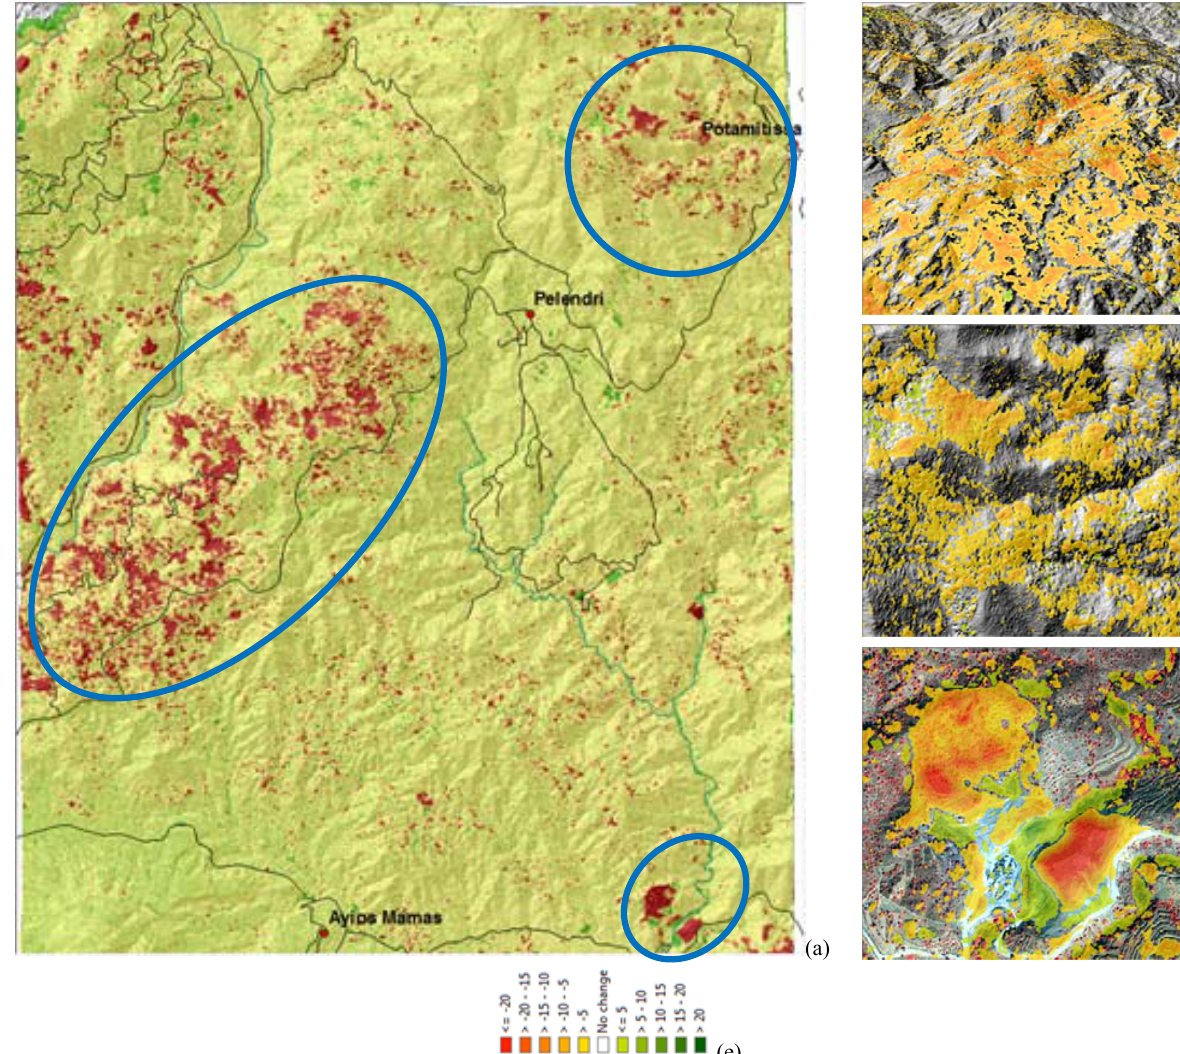
Figure 10. Change map (a); 3D view of west ellipse region (b), north-east circle region (c), and south-east small ellipse region (d). Legend showing difference in height in meter unit (e). FORSAT Consortium © copyright. All rights reserved.